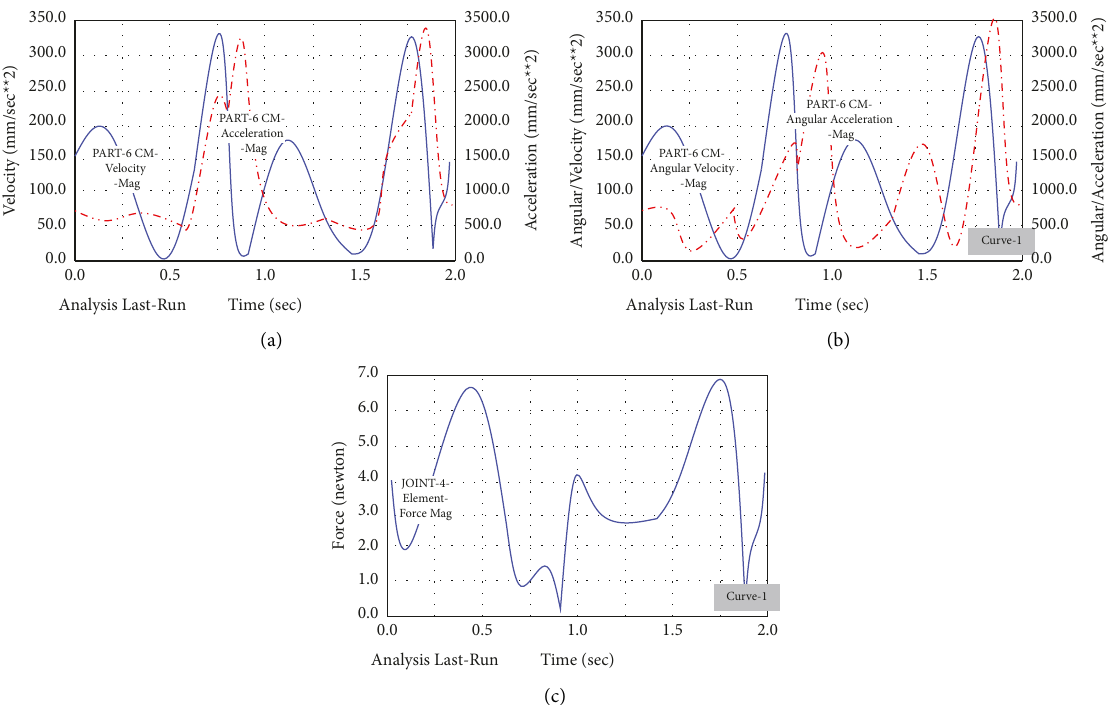
Figure 10: Simulation test: (a) the variation curve of baling needle speed and acceleration, (b) the variation curve of baling needle angular velocity and angular acceleration, and (c) the variation curve of baling needle